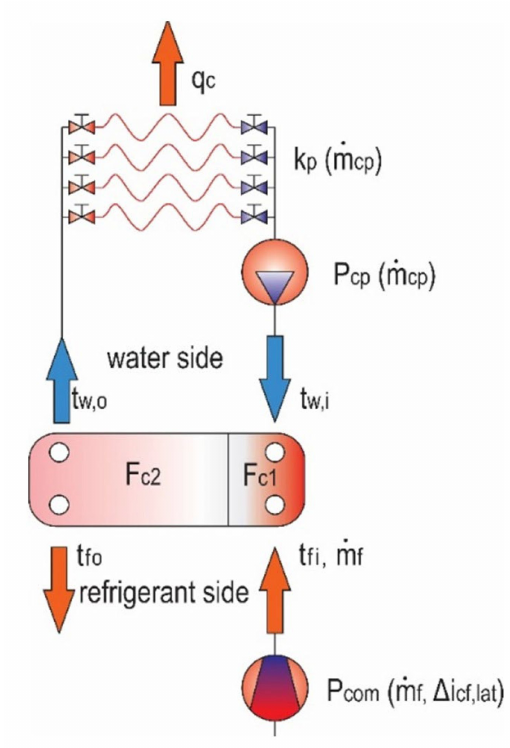
Figure 2. Warm water loop with heat flows, powers, and